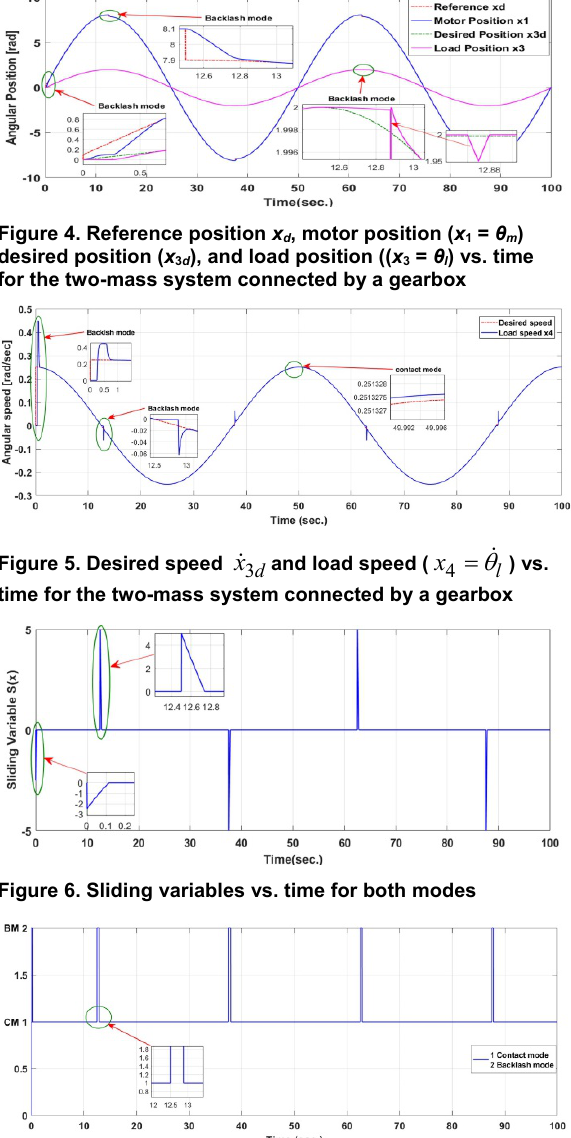
Figure 7. Backlash and contact modes of the system behavior